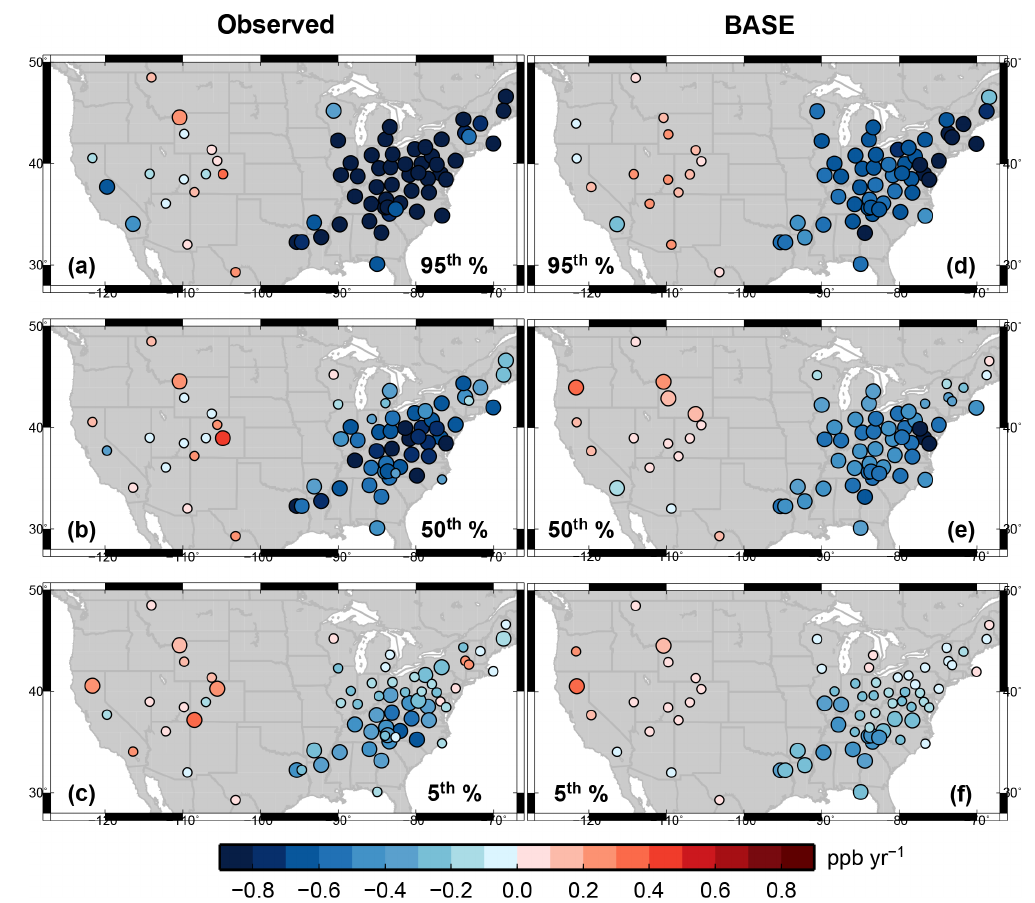
Figure 8. As in Fig. 7, but for summer (JJA). Note that the color scale saturates at ±